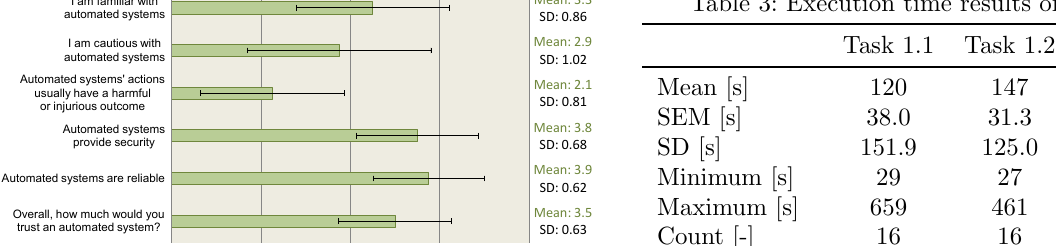
Figure 7: Results of survey on trust in automation, SD: Standard Deviation